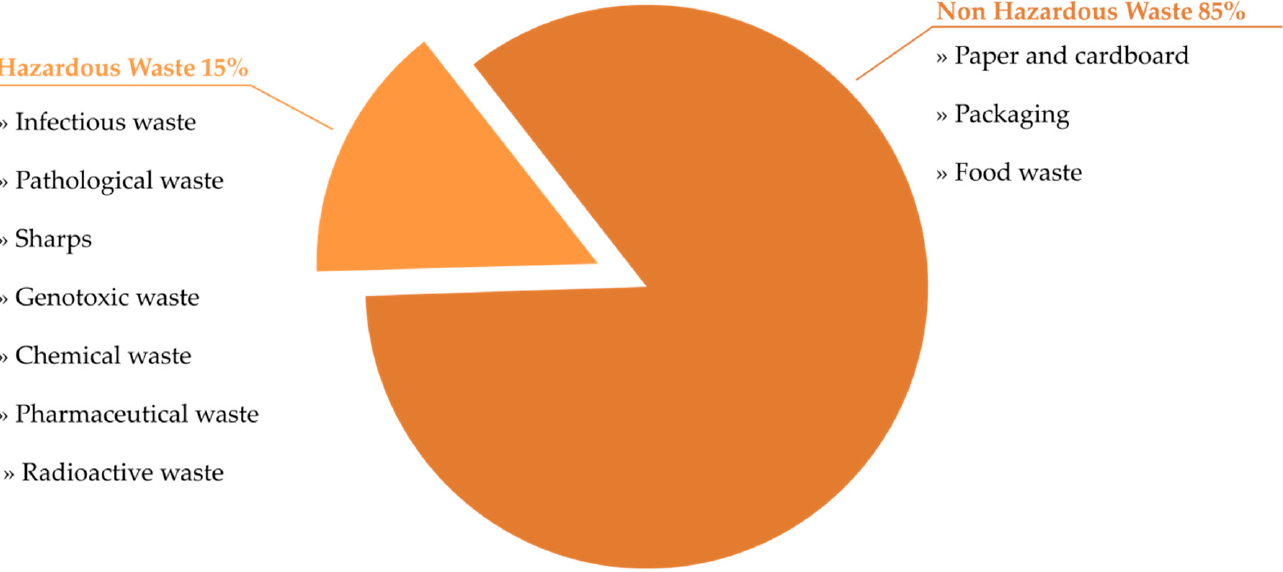
Figure 1. Standard waste composition in health facilities.